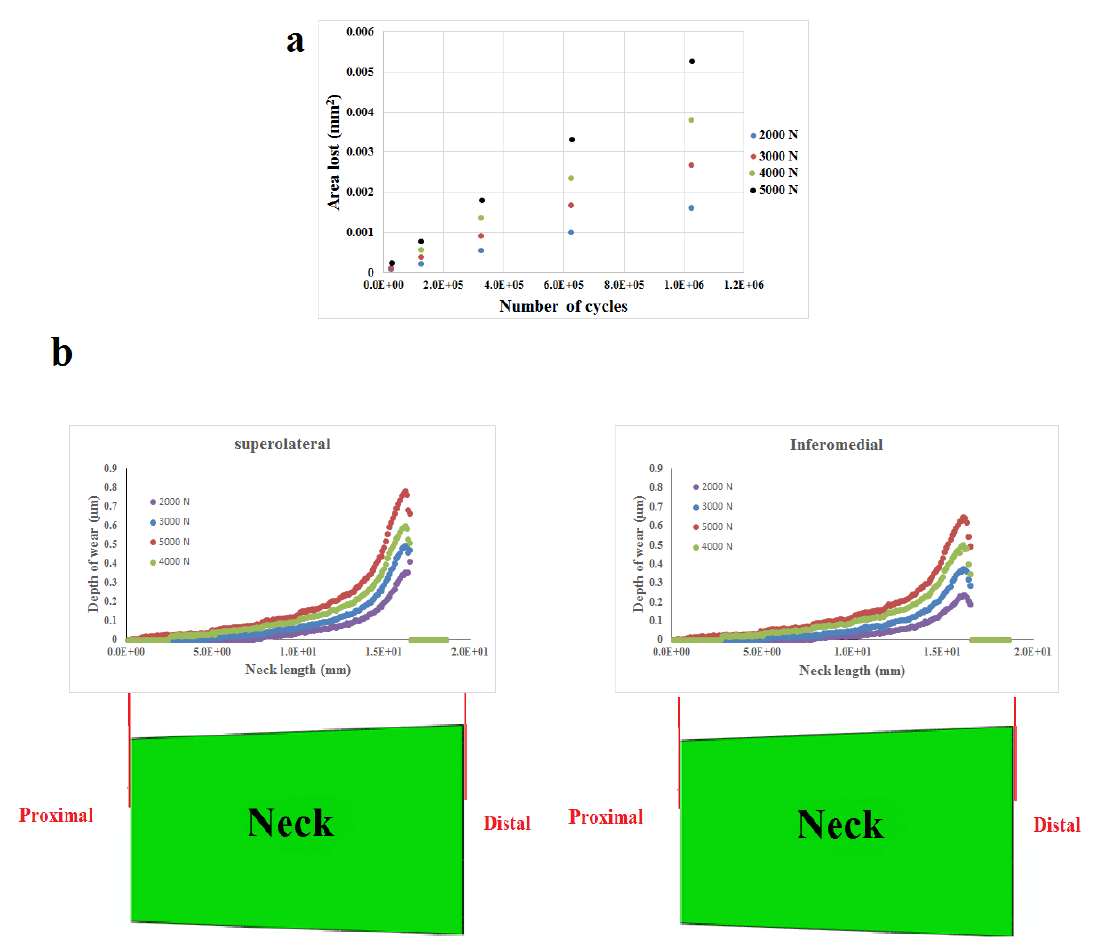
Figure 6. ( a ) Lost area versus number of cycles for different assembly forces and ( b ) depth of wear over the neck length after 1,025,000 cycles.